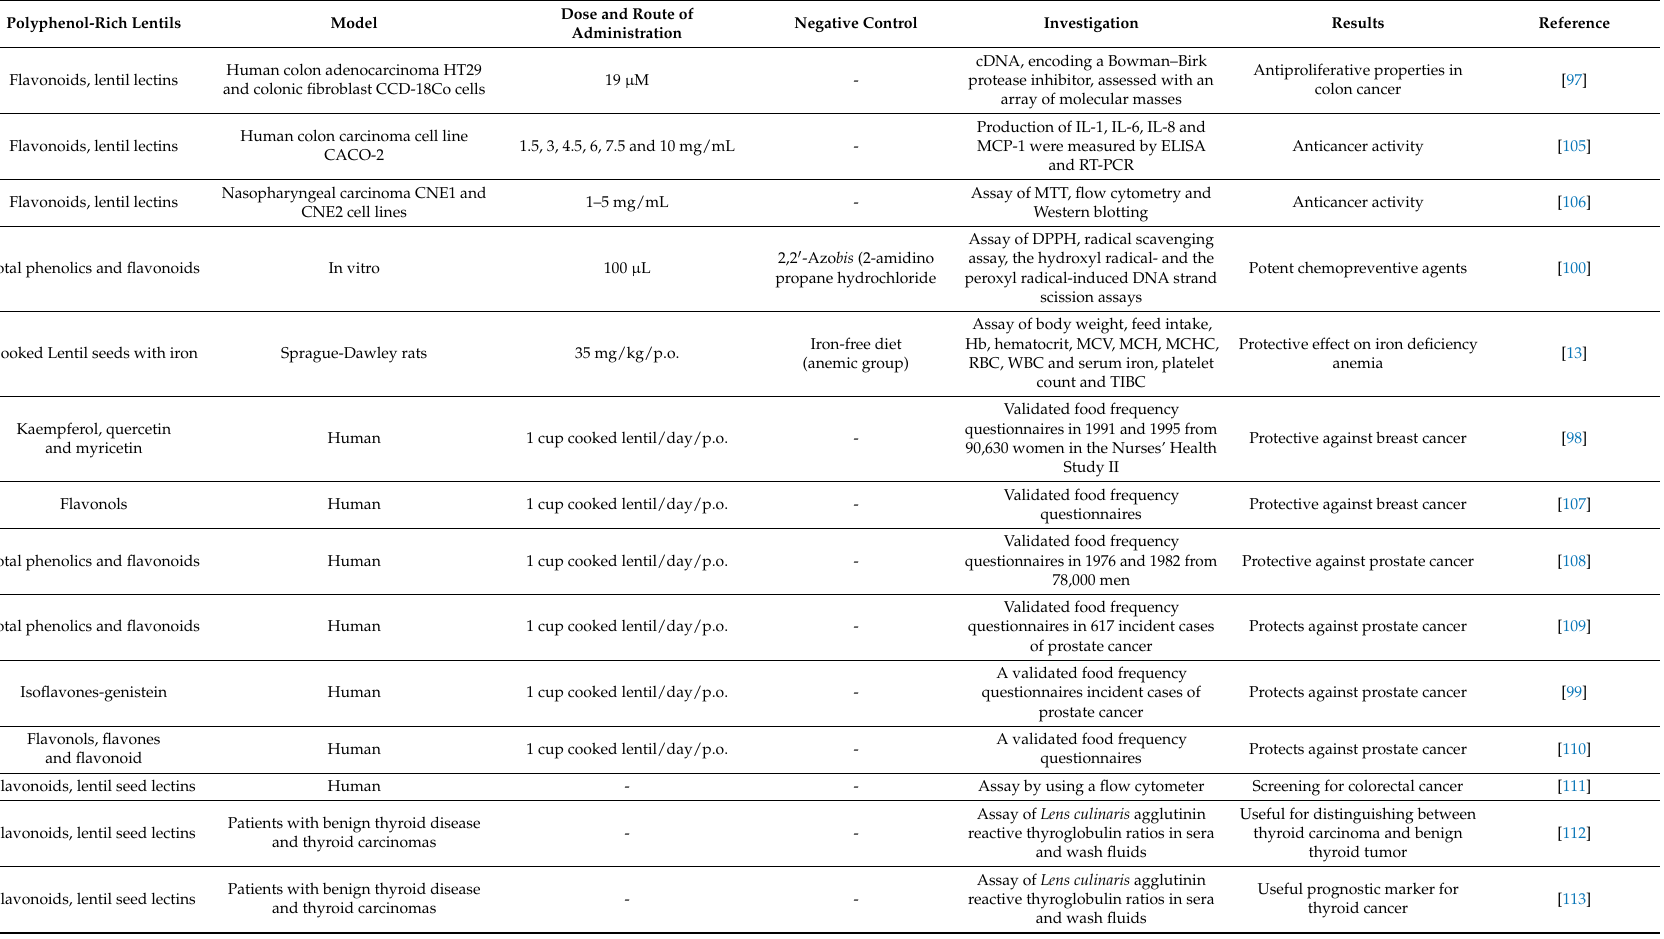
Table 8. Summary of in vitro, in vivo and clinical studies on the anticancer and chemopreventive effects of polyphenol-rich